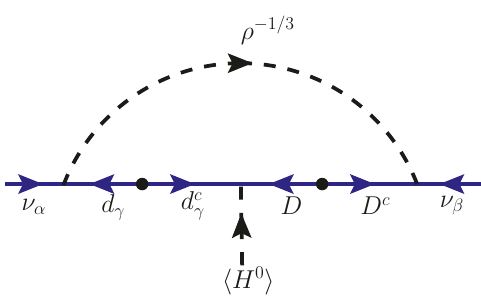
Figure 41 . Neutrino mass generation in the one-loop triplet LQ model with vectorlike quarks. This model corresponds to